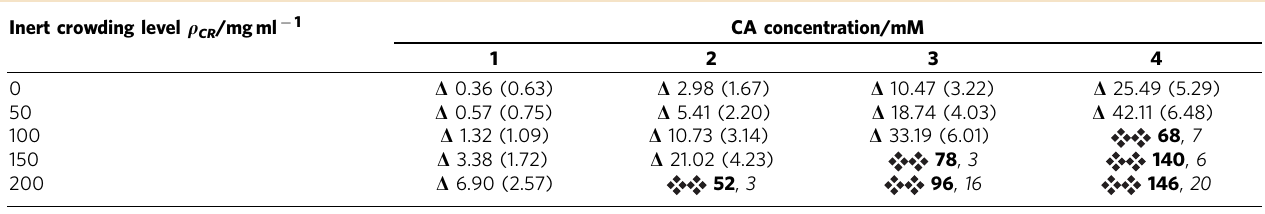
CG, coarse-grained. Triangles ( D ) indicate simulations producing only steady-state CA trimer-of-dimers populations (average trimer count listed, s.d. in parentheses). Entries marked denote production of multiple lattice regions. Hexamer (bold typeface) and pentamer (italics) counts shown after 2 (cid:3) 10 8 CGMD time steps.